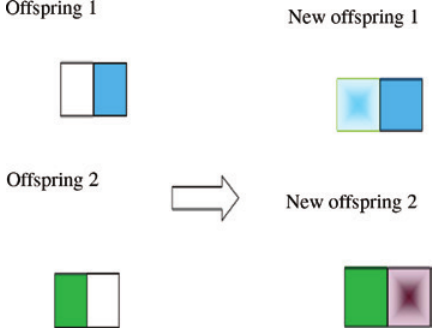
Figure 5: Mutations.